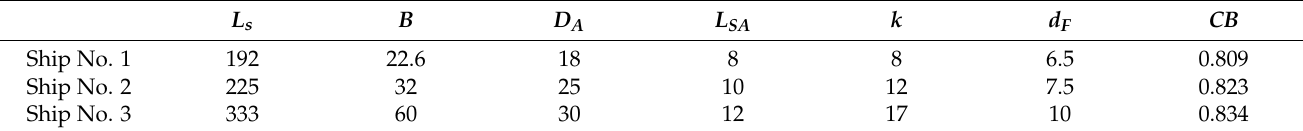
Table 2. Ship type parameters selected for the simulation experiment (unit: